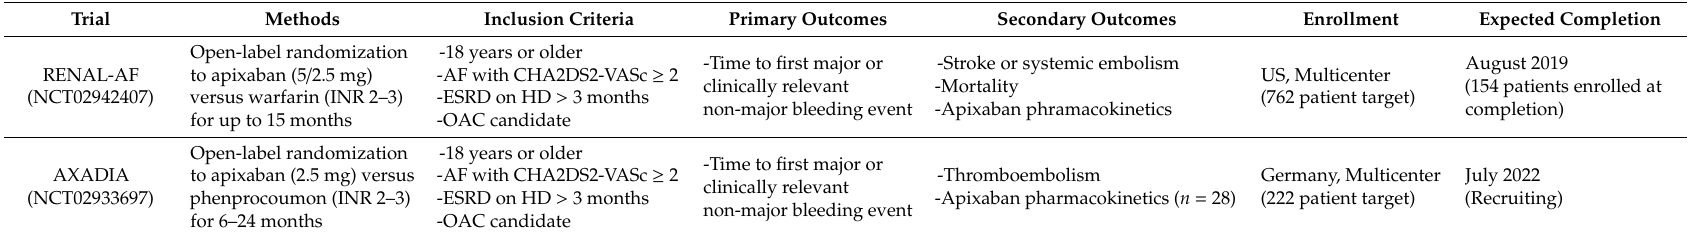
Table 2. Summary of prospective randomized trials evaluating the e ffi cacy and safety of apixaban versus warfarin in end-stage renal disease patients with atrial